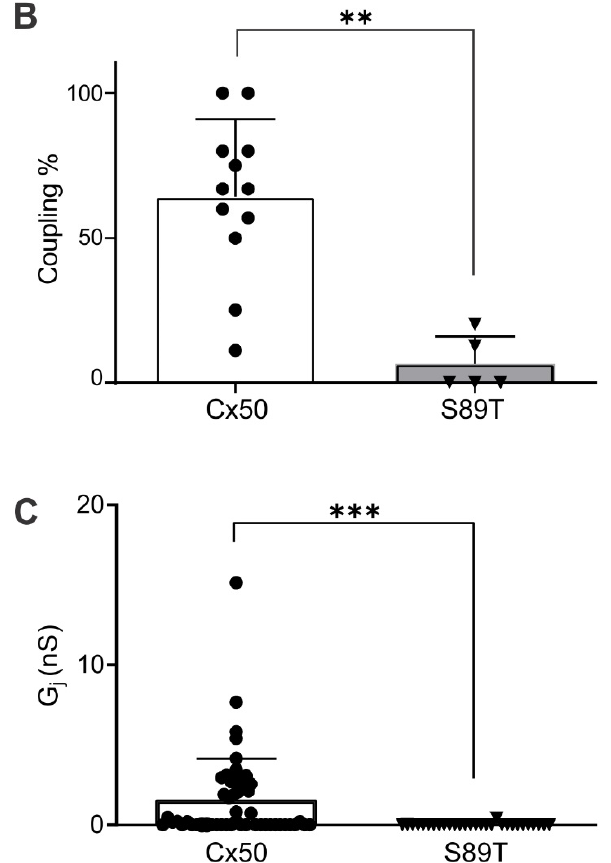
Figure 10. Cx50 S89T failed to form functional GJs. ( A ) A representative I j was recorded from a cell pair expressing Cx50 S89T. No current response was detected with a V j pulse of 20 mV, indicating that S89T failed to form any functional GJs. ( B , C ) Summarized bar graphs to show coupling% from five transfections and G j of Cx50 S89T (n = 29 cell pairs), respectively. In both cases, S89T showed a significant reduction in coupling% (** p = 0.0011 with Mann–Whitney test) and G j (*** p < 0.001 with Mann–Whitney test).